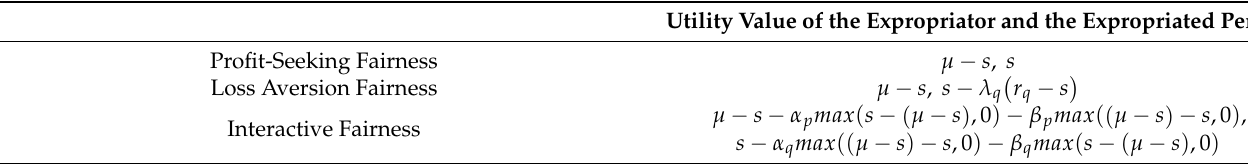
Table 6. Compensation scheme for urban housing expropriation 3 (unfair expropriation, acceptance). Utility Value of the Expropriator and the Expropriated Person Profit-Seeking